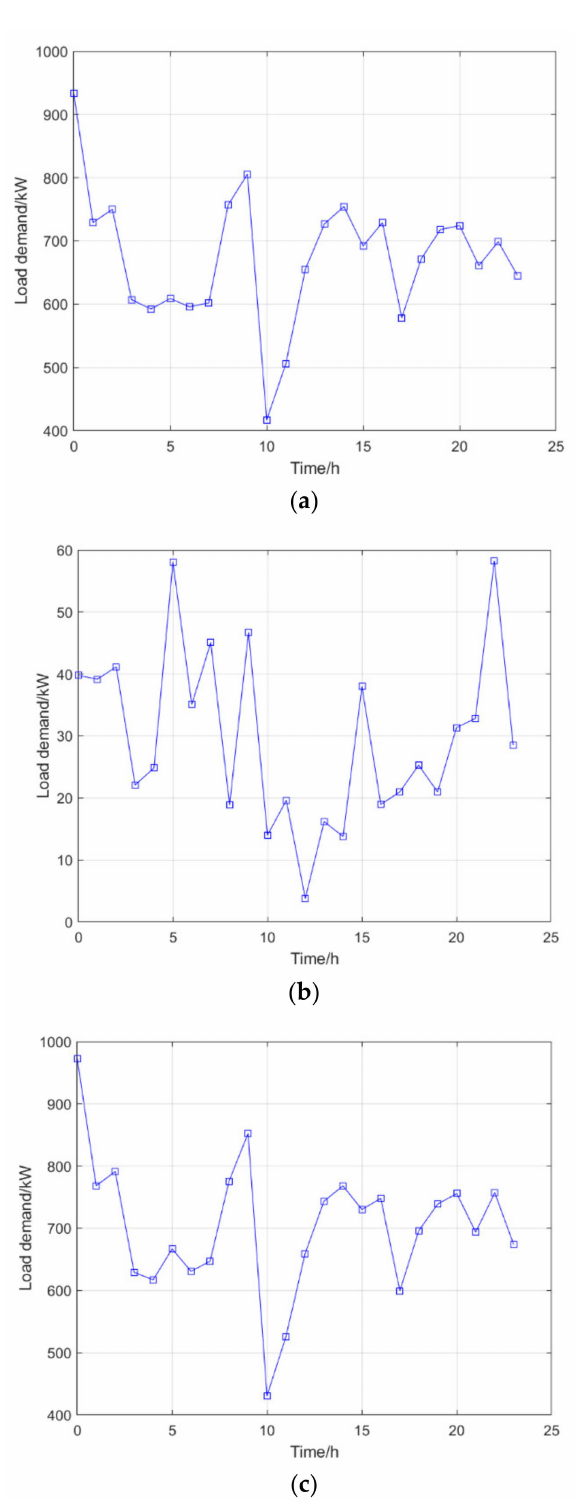
Figure 18. Fast charging demand load at 50 electric taxis. ( a ) Charging demand generated by electric taxis in charging stations. ( b ) Charging demand for electric taxis at their current location. ( c ) Charging needs generated by electric